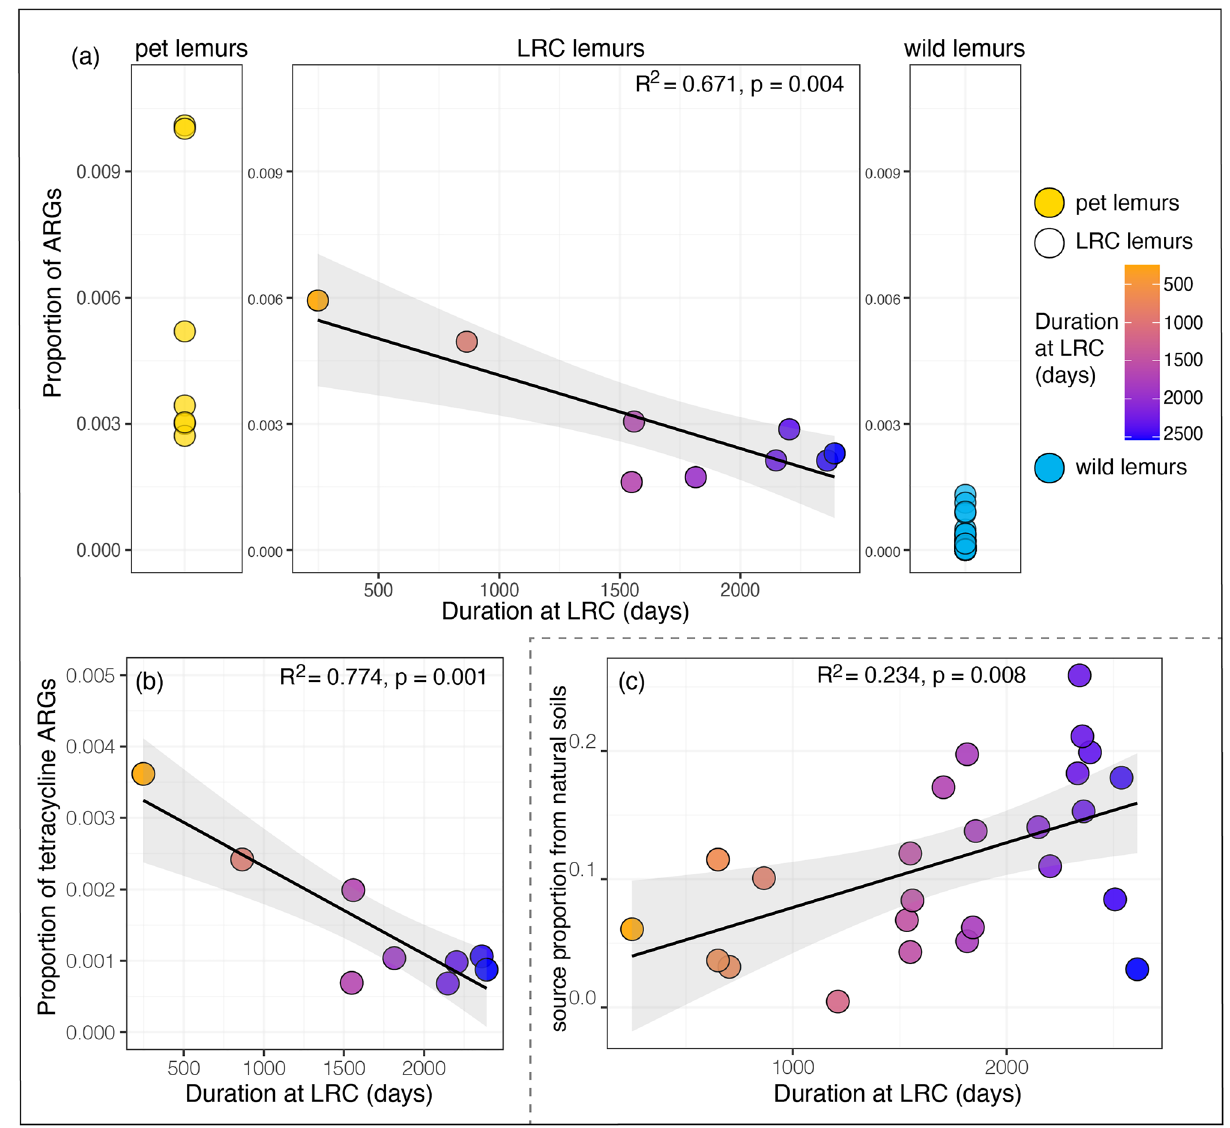
Figure 2. Environmental influences on the gut microbiomes (GMBs) of three categories of ring-tailed lemurs ( Lemur catta ) in Madagascar. Relative abundances of ( a ) total antibiotic resistance genes (ARGs) in wild lemurs (blue), pet lemurs (yellow), and lemurs in semi-natural conditions at the Lemur Rescue Center (LRC; color- graded in relation to duration in residency) and ( b ) tetracycline ARGs in the GMBs of LRC lemurs. ( c ) Total source proportion of soil microbes from natural habitats in the GMBs of LRC lemurs. Shown are linear trend lines and 95% confidence intervals. See Table 2 for full statistical results from linear mixed